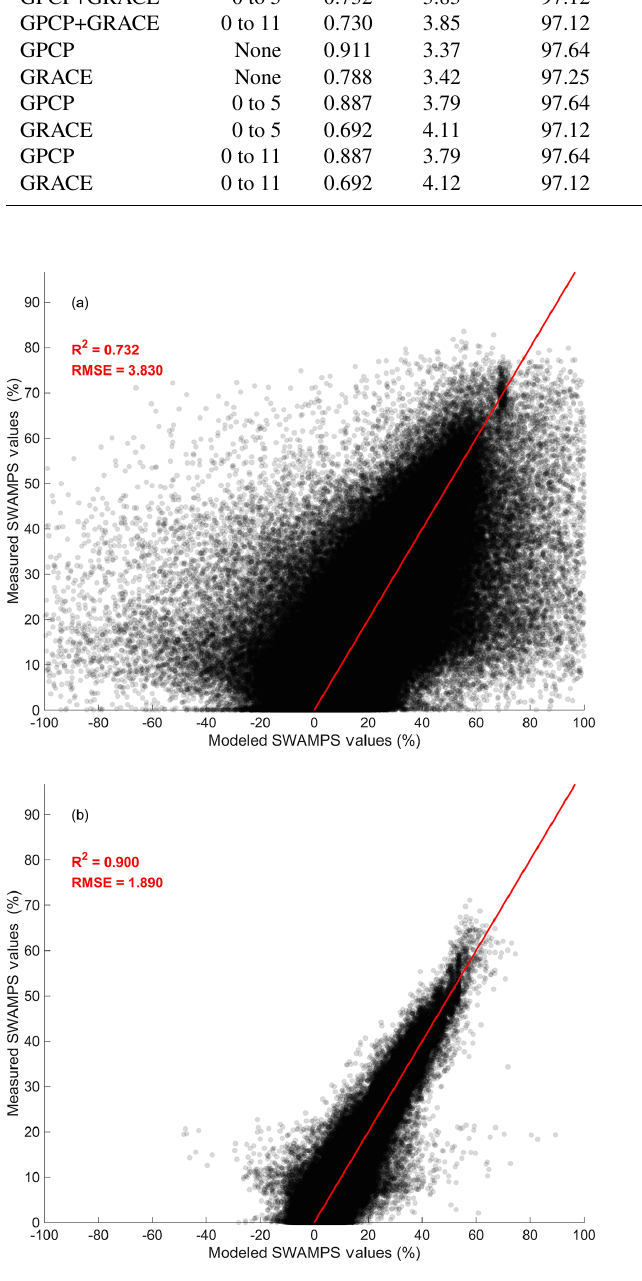
Figure 5. Example of multi-linear regression model validation plots. (a) Measured versus modeled SWAMPS data with a time lag correction of 0 to 5 months. (b) Fig. 5a after locations with less than 50% probability of validity are removed.